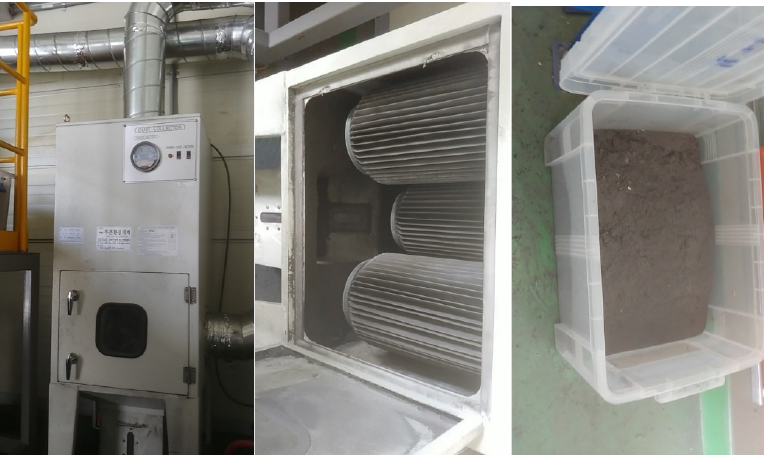
Figure 1. Collection of the industrial dust in the refinery.